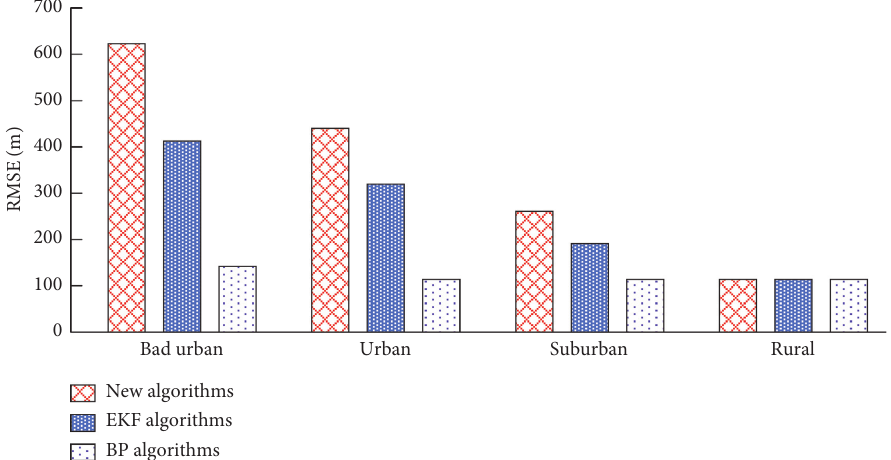
Figure 11: RMSE location error of different algorithms under different